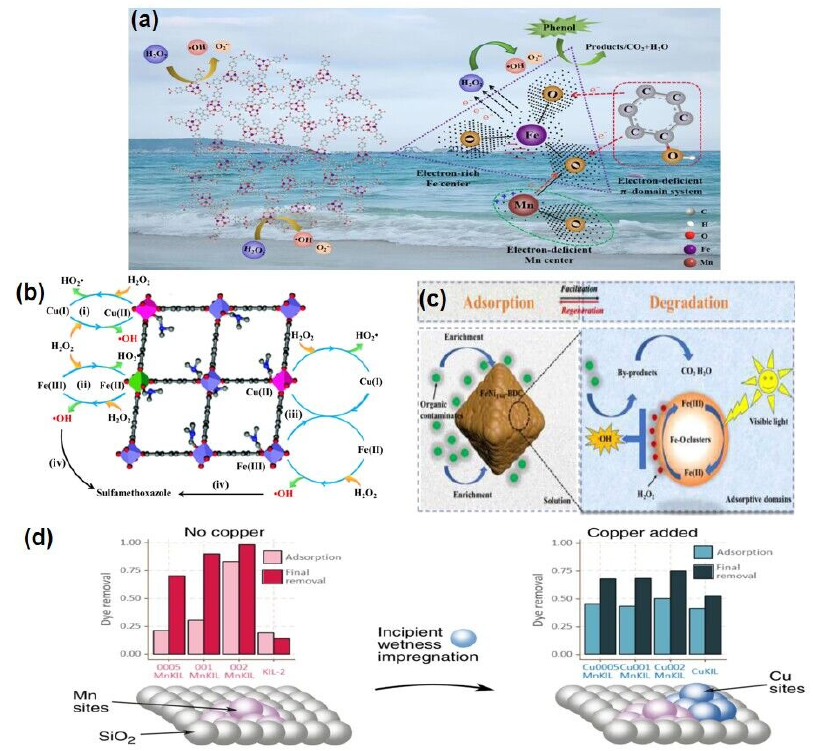
Figure 5. ( a ) Schematic for the reaction mechanism in MIL-101(Fe II 3 , Mn)/H 2 O 2 /phenol system [46]; ( b ) Schematic illustration of SMX removal in the Fe 0.75 Cu 0.25 (BDC)/H 2 O 2 system [47]; ( c ) Reaction mechanism of contaminant degradation in FeNi 1/60 -BDC/H 2 O 2 /visible light system [58]; and ( d ) Schematic illustration of CuMnMIL and comparison before and after degradation [59].